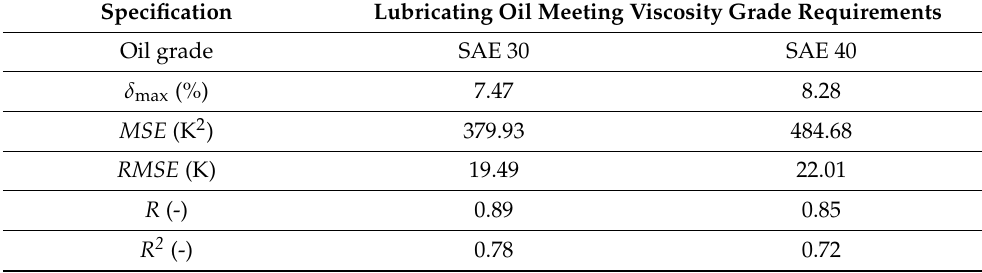
Table 5. Indicators describing the model’s goodness of fit to the experimental